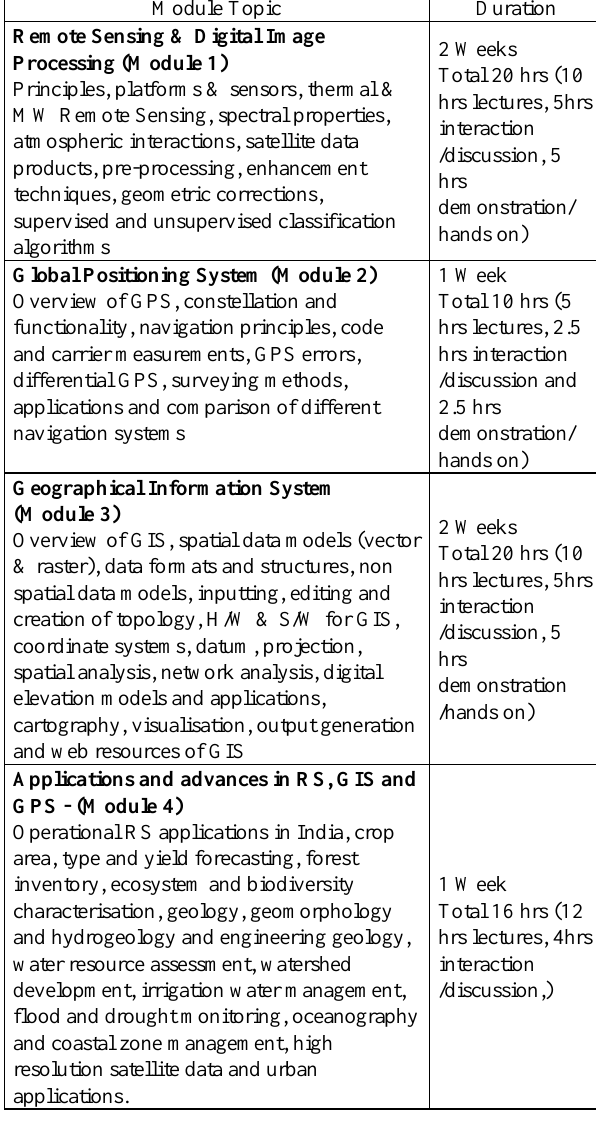
Table 5. Course Curriculum of ―Advances in Geoinformatics‖